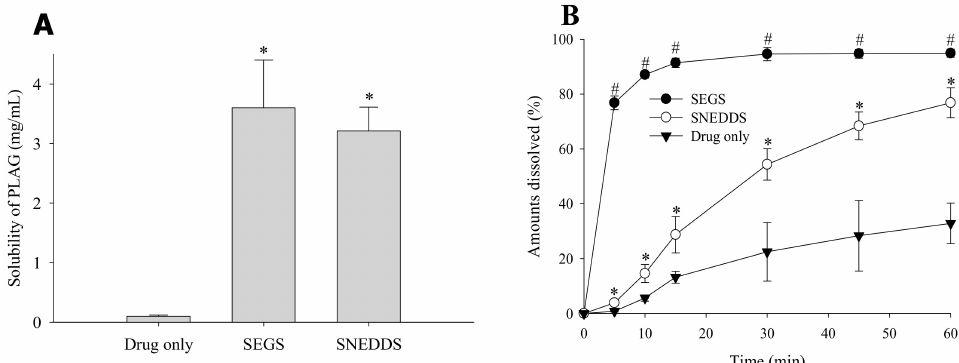
Figure 8. Drug solubility ( A ) and dissolution profile ( B ) of SEGS and SNEDDS in the pH 6.8 bu ff er containing2.5%SLS.TheSEGSandSNEDDSwerecomposedofPLAG / SLS / HPMC / calciumsilicate / MCC at the weight ratio of 1:0.25:0.1:0.5:3. Each value designates the mean ± S.D. ( n = 6). * p < 0.05 compared with drug only; # p < 0.05 compared with drug only and